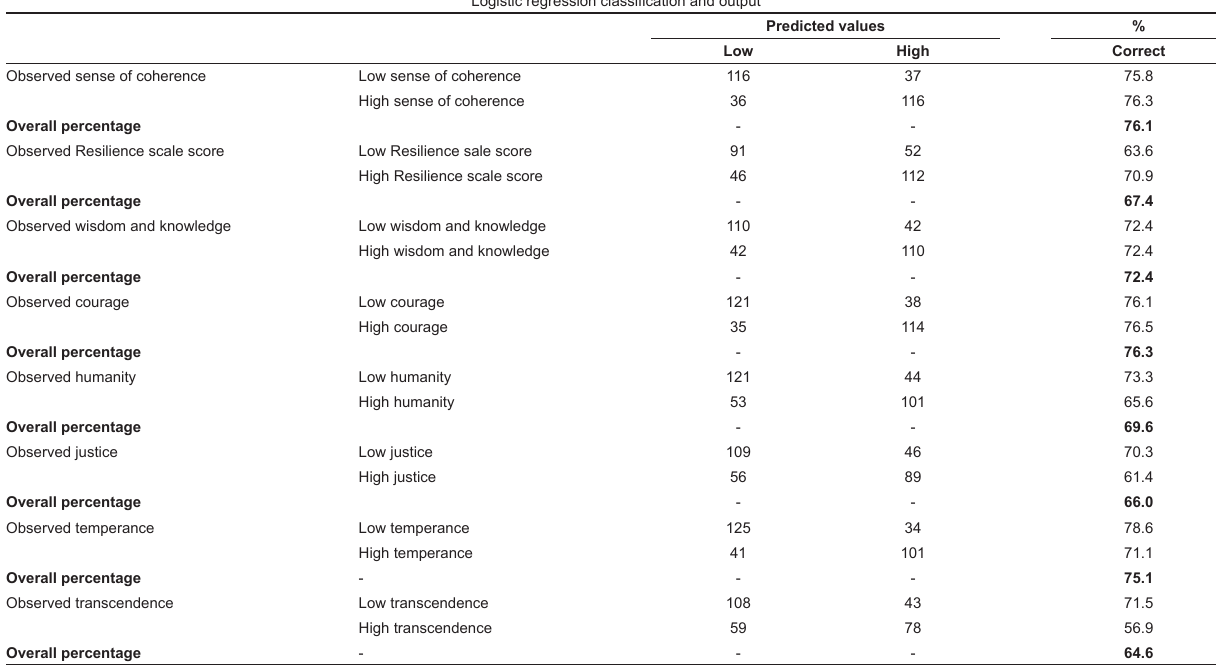
TABLE 3 Logistic regression classification and